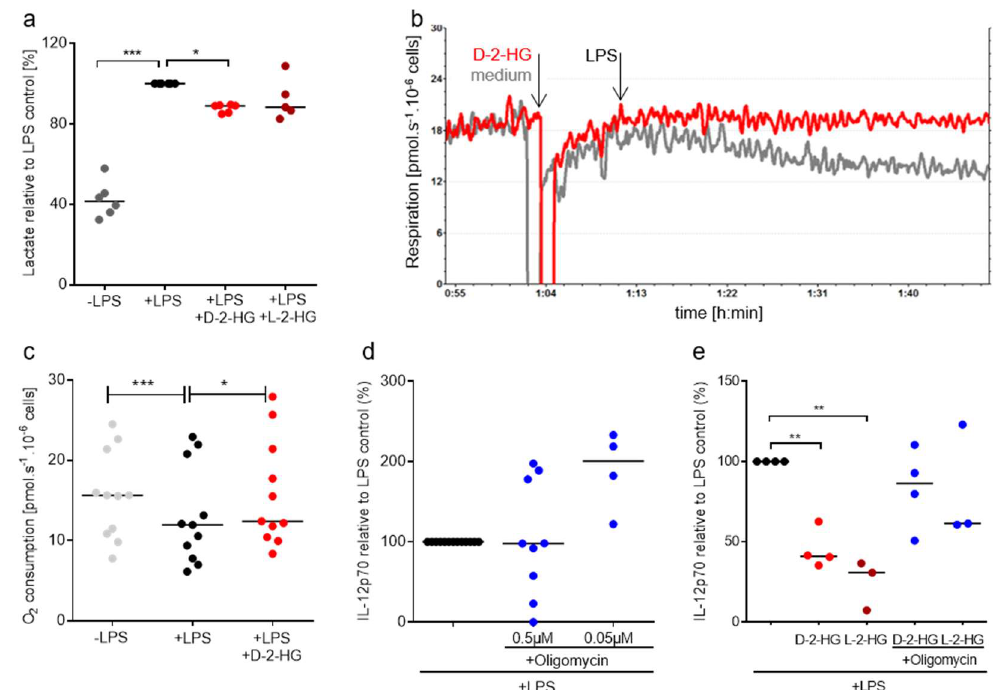
Figure 5. 2-HG reprograms DC metabolism and thereby reduces IL-12 secretion. ( a ) Lactate secretion was determined in supernatants of DCs incubated in the presence or absence of 2-HG. ( b , c ) Monocyte-derived DCs were placed in oxygraph chambers in culture medium. After stabilization of respiration, 2-HG or medium was added to the chambers. After 10 min, cells were activated with 100 ng/mL LPS and oxygen consumption was monitored for one hour. ( b ) One representative experiment out of eight is shown. ( c ) Data represent the median of 11 independent experiments. Statistical testing was performed using a RM One-Way ANOVA test with Holm Sidak’s multiple comparison test (* p ≤ 0.05). ( d ) To evaluate the effect of oligomycin on IL-12 production by DCs, 0.2 × 10 6 monocyte-derived DCs were plated in 24-well plates and treated with 100 ng/mL LPS and the indicated concentrations of oligomycin. IL-12 was measured in supernatants by commercially available ELISA. Data represent the median of at least four independent experiments. Statistical significance was tested using the Kruskal Wallis test. (* p ≤ 0.05). ( e ) Monocyte-derived DCs were plated in 24-well plates and treated with 100 ng/mL LPS and with 2-HG in combination with oligomycin. IL-12 was measured in supernatants by commercially available ELISA. Data represent the median of at least four independent experiments. Statistical significance was tested using the Kruskal Wallis test. (* p ≤ 0.05, ** p ≤ 0.01, *** p ≤ 0.001).